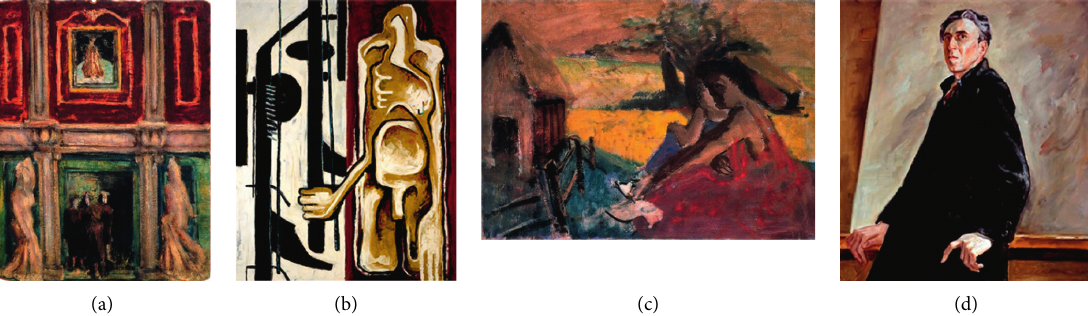
Figure 23: Multiplex MultiRank top 4 paintings in the dataset between 1934 and 1952. (a) Mark Rothko: Interior 1936 (Expressionism). (b) Clyfford Still: PH 343 1937 (Expressionism). (c) Mark Rothko: Rural Scene 1936 (Expressionism). (d) Clyfford Still: Self-portrait PH 382 1940 (Expressionism).